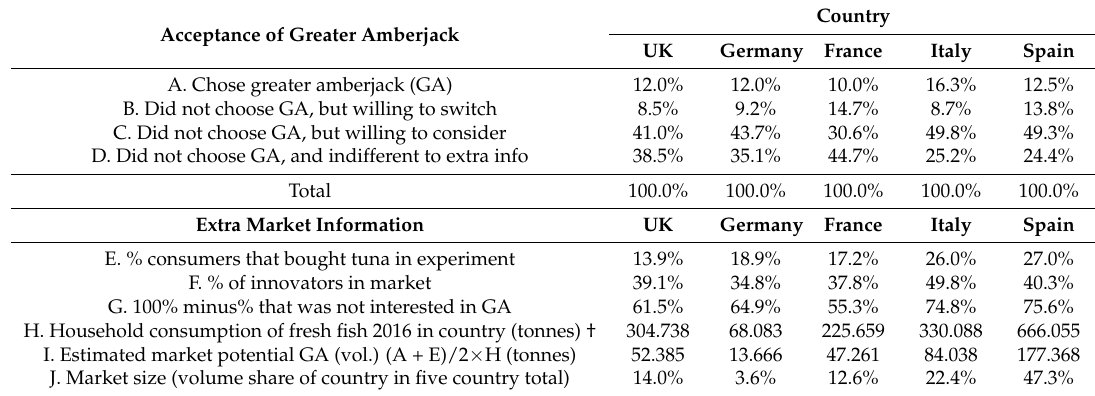
Table 1. Acceptance of greater amberjack by consumers in the five target countries.